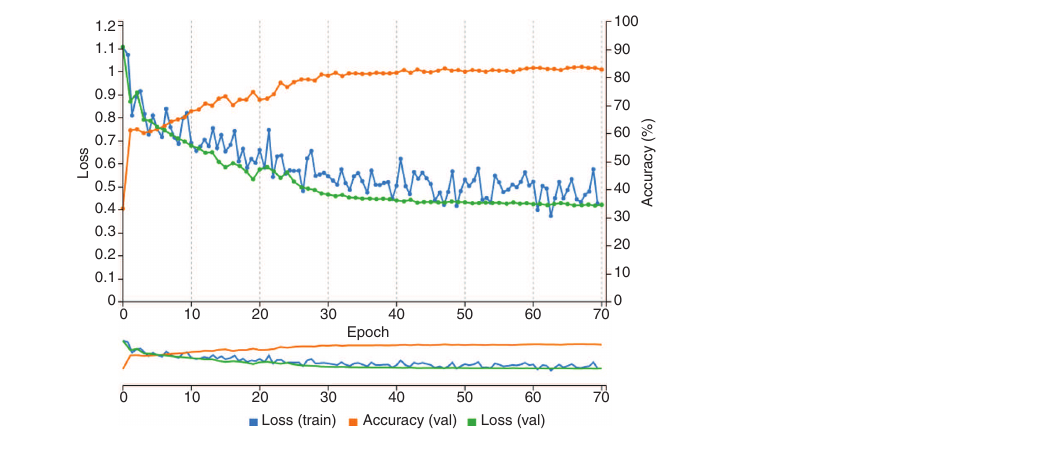
Figure 27: Training Process of Experiment 3.